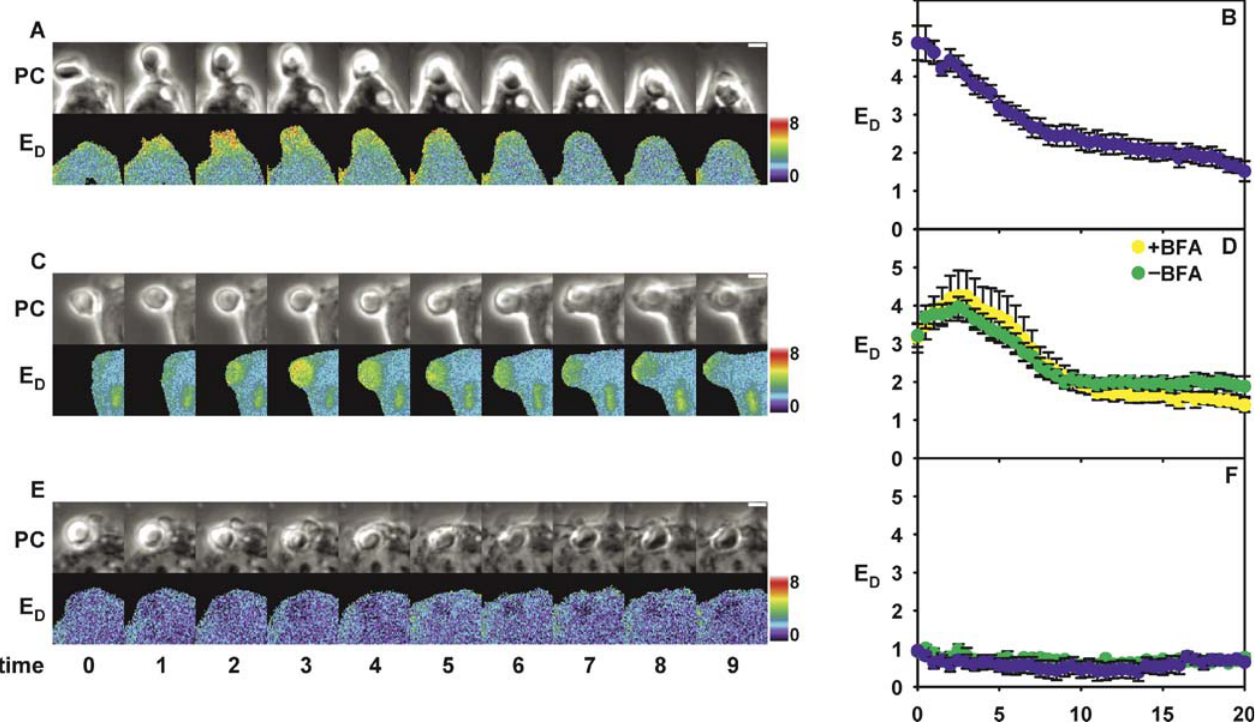
Figure 3. Measurement of ARF6-CFP and ARF1-CFP Activation at Phagosomes FRET microscopic measurement of ARF6-CFP and ARF1-CFP activation during phagocytosis. (A, C, and E) Phase contrast and E D images of phagocytic events from macrophages co-expressing ARF6-CFP and YFP-NGAT, ARF1-CFP and YFP-NGAT, or ARF6-CFP and YFP-mutant NGAT. Scale bars in the upper right of the phase contrast series are 3 l m. (B, D, and F) Plots of E D against phagosome progress for the corresponding pairs in (A), (C), and (E). Error bars indicate 6 SEM. (A) ARF6-CFP activation peaked shortly after particle binding. Activated molecules were concentrated at the leading edge of the phagosome with lower levels of ARF6-GTP in the region trailing the advancing edge of the pseudopod. (B) Based on compiled particle-tracking results, maximum ARF6-CFP activation occurred shortly after the initiation of phagocytosis, and most of the ARF6-CFP was deactivated by the time of closure ( ; 7–8 min after the initiation of phagocytosis); n ¼ 11 phagocytic events. (C) The peak in ARF1-CFP activation was slightly delayed relative to ARF6-CFP, and ARF1-GTP was not restricted to a subregion of the phagosome. ARF1-GTP levels began to decrease as the closure phase began. The persistent Golgi-associated FRET signal indicated ARF1-GTP levels at the Golgi did not fluctuate during